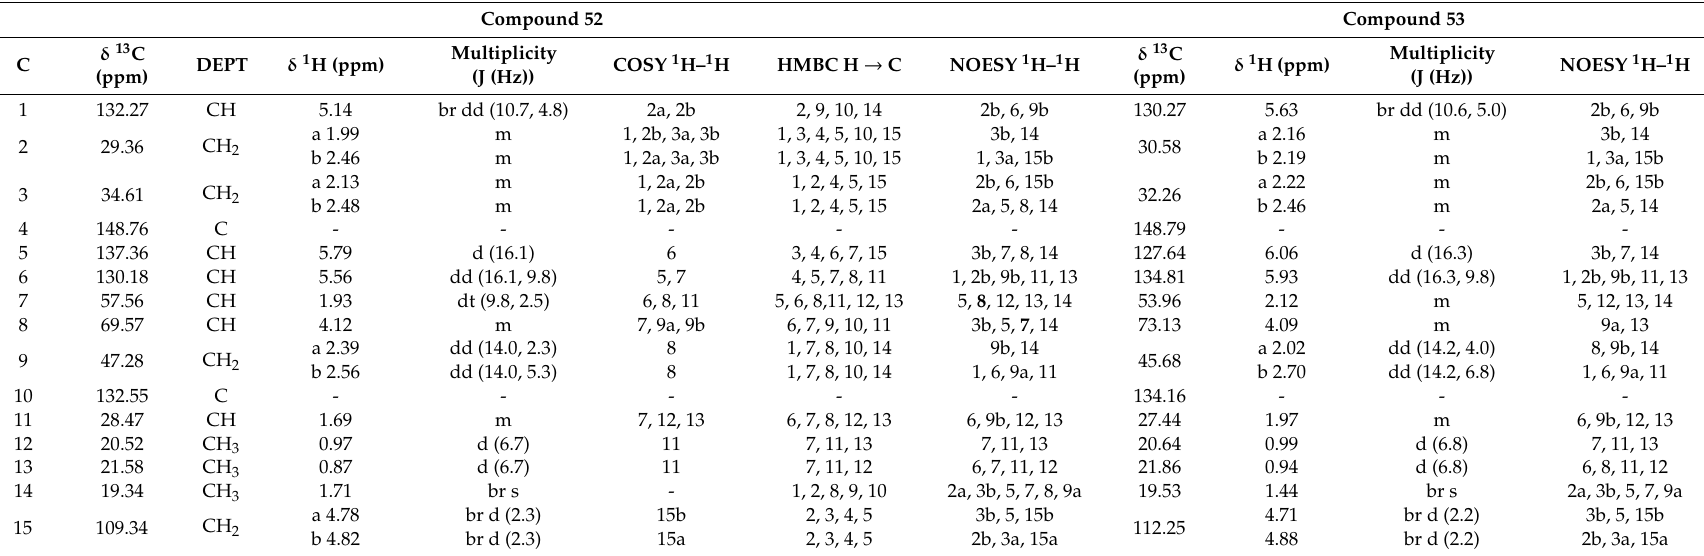
Table 2. NMR data of compounds 52 and 53